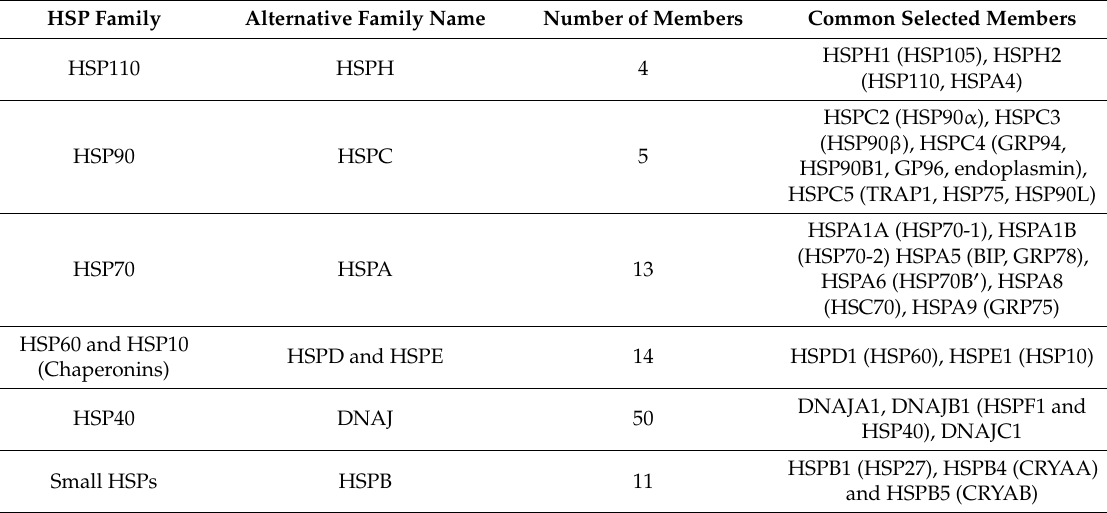
Table 1. Summary of heat shock proteins (HSP) families and their common